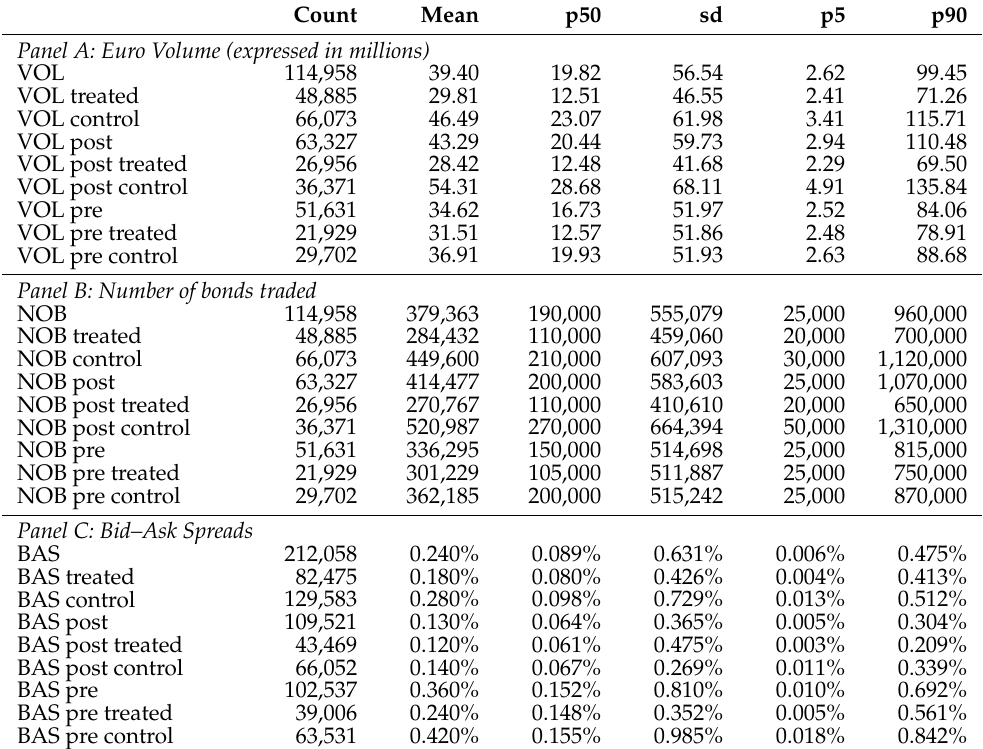
Table 3. Descriptive statistics for volume and